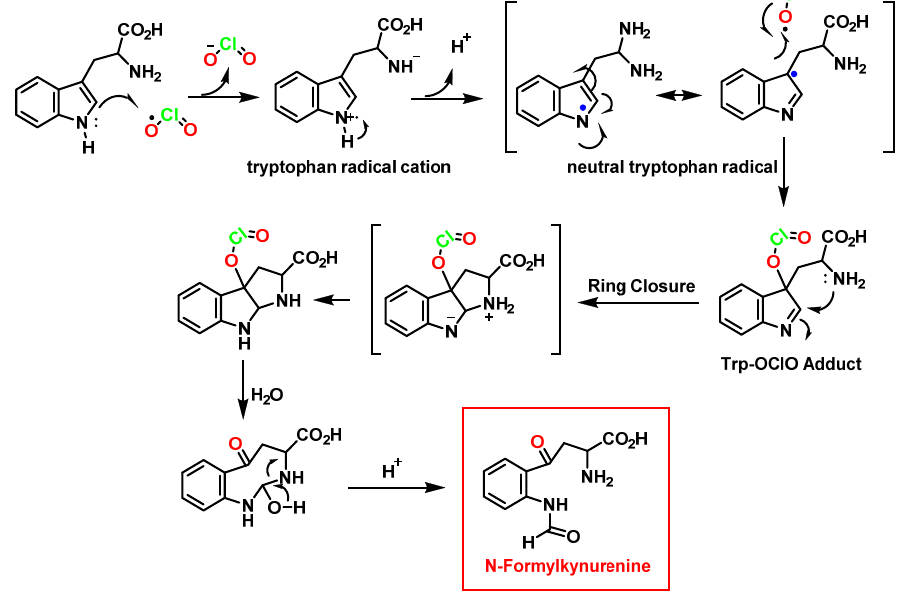
Figure 39. Proposed reaction mechanism for the attack of ClO 2 to tryptophane. The reaction consumes two ClO 2 per Trp and forms chlorite and HOCl (Figure 40).